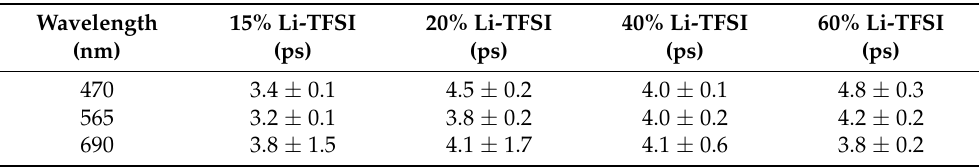
Table 1. Optical changes in the Au LSPR absorption maximum due to changes in spiro-OMeTAD conductivity caused by changes in Li-TFSI concentration.